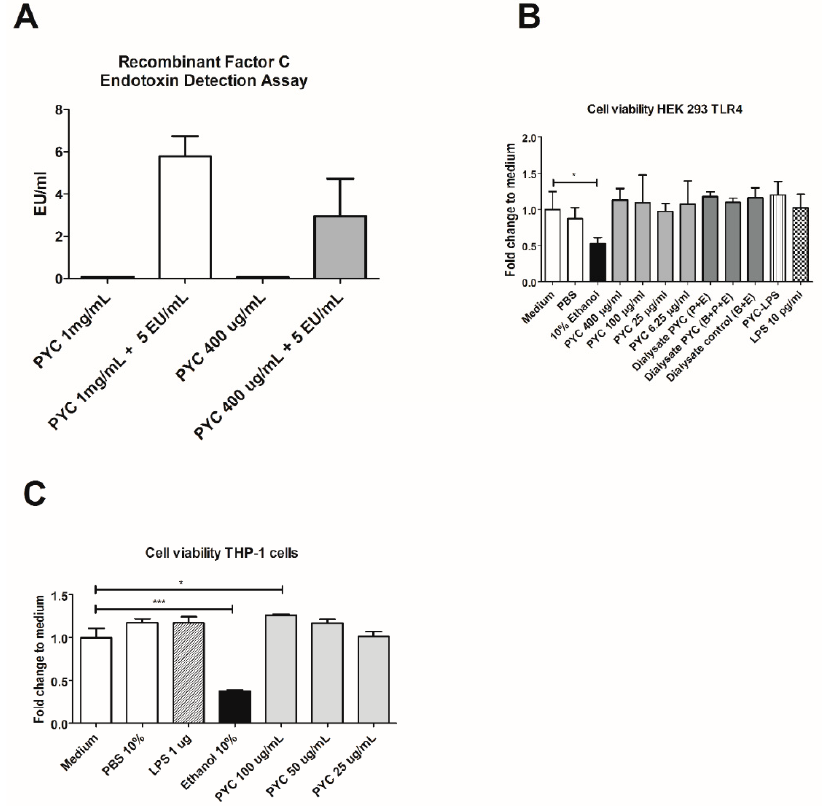
Figure 2. PYC extract contains non-detectable amounts of LPS and does not influence the viability of Human Embryonic Kidney (HEK)-Blue 293 and Human Acute Monocytic Leukaemia (THP-1) cell lines. ( A ) Lipopolysaccharide (LPS) concentration in Pycnogenol ® (PYC) extract without and after spiking with 5 EU/ml of LPS detected with EndoZyme recombinant factor C assay ( n = 4 as technical replicates). Spiking recovery between 50% and 200% excludes interference of sample components with the assay. ( B ) Viability of HEK-293 cells expressed as fold change of absorbance (490 nm) compared to unstimulated cells cultured in medium as control ( n = 4 as technical replicates). ( C ) THP-1 macrophages cultured for 24 h in the presence of PYC. Results are expressed as fold change of absorbance (490 nm) comparedto unstimulated cells cultured in medium as control ( n = 4 as technical replicates). Ethanol was used as the positive control that affects cell viability. All data are expressed as the mean ± standard deviation (SD). p -values < 0.05 are considered statistically significant, as analyzed with one-way ANOVA with Tukey post hoc comparison test (GraphPad Prism). Significant differences are indicated by asterisks: * p < 0.05; *** p < 0.001.